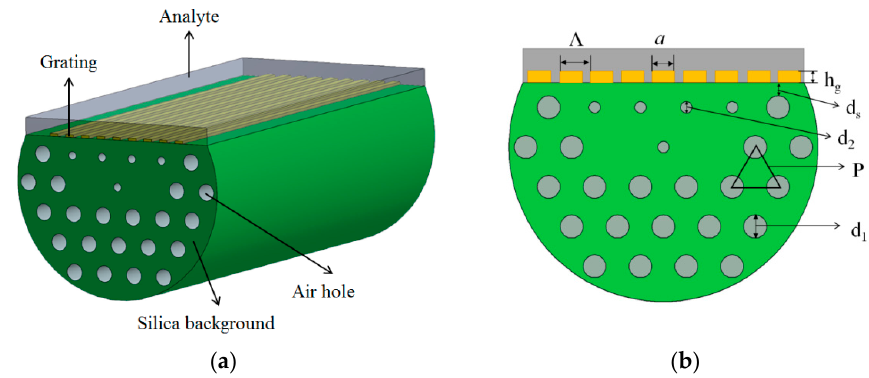
Figure 1. ( a ) The 3D view and ( b ) cross section of the proposed D ‐ shaped PCF.